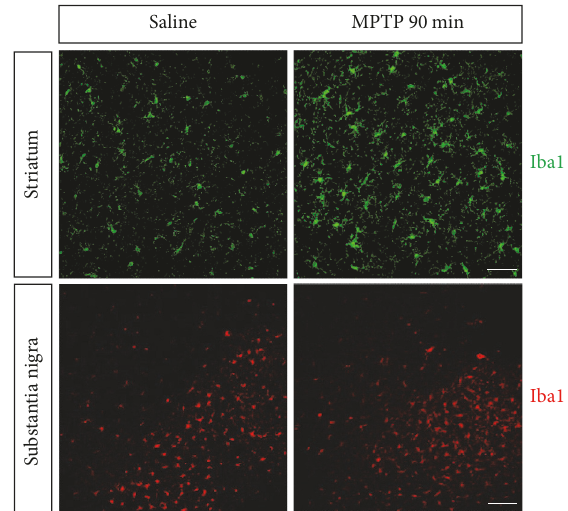
Figure 1: Microglial cells in the nigrostriatal pathway at 90 min after acute MPTP treatment. Immunofluorescence staining for Iba1 (green) in the striatum (scale bar: 0.05 mm) and immunofluores- cence staining for Iba1 (red) in the SN (scale bar: 0.1mm) were shown. This figure is adapted from Liu et al., scientific reports 5:15720